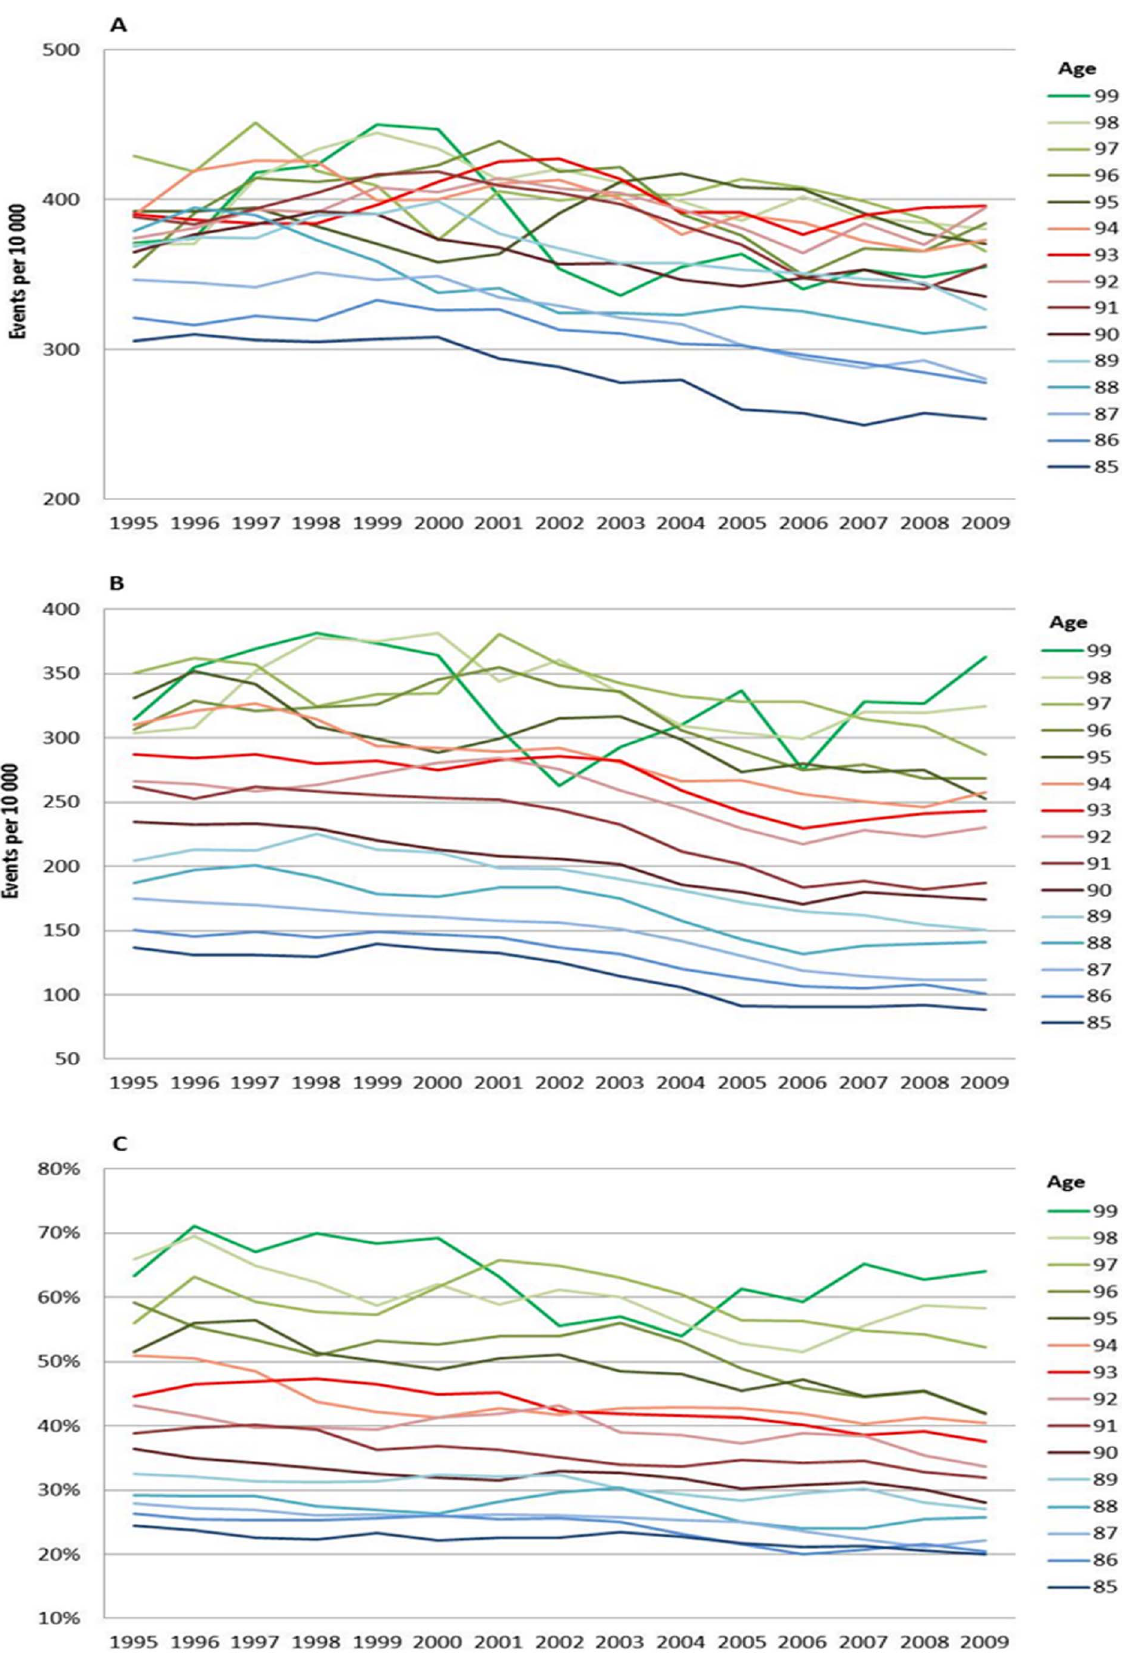
Figure 6. Stroke incidence (A), mortality (B) and case fatality (C), women. Age specific trends in stroke, women, between 1994 and 2010. One year cumulative incidence (A), overall mortality (B), and, case fatality within 28 days, percent (C). Three year moving average. doi:10.1371/journal.pone.0064928.g006 PLOS ONE |